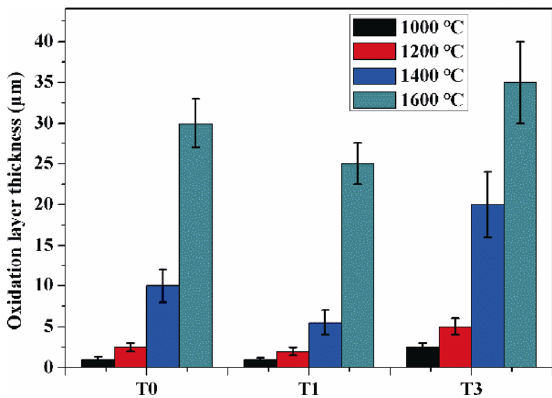
Fig. 12 Oxidation layer thicknesses of Si 2 BC 3 N